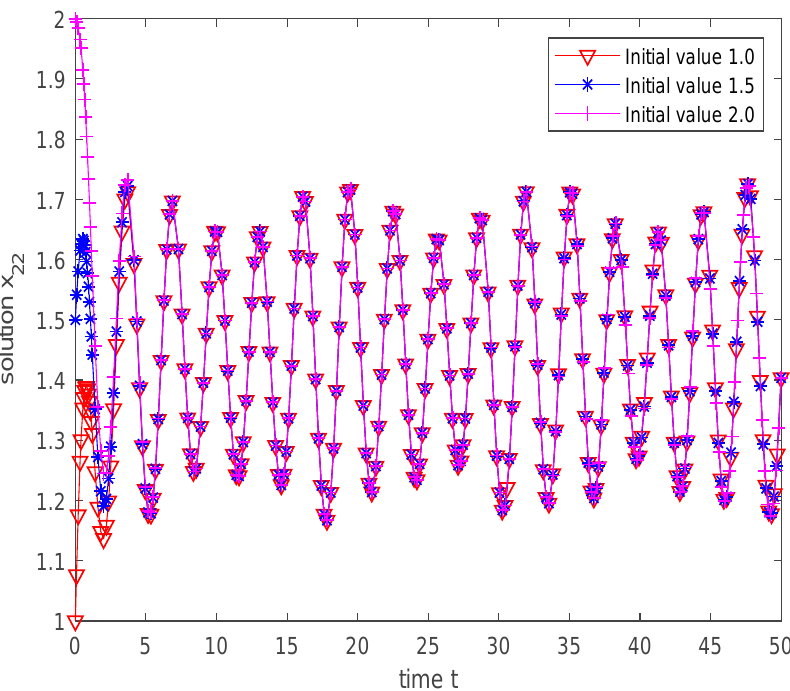
x , and initial values are 1.0,1.5, 2.0, respectively. Figure 2. The state trajectory of x 22 , and initial values are 1.0,1.5,2.0, respectively. 22